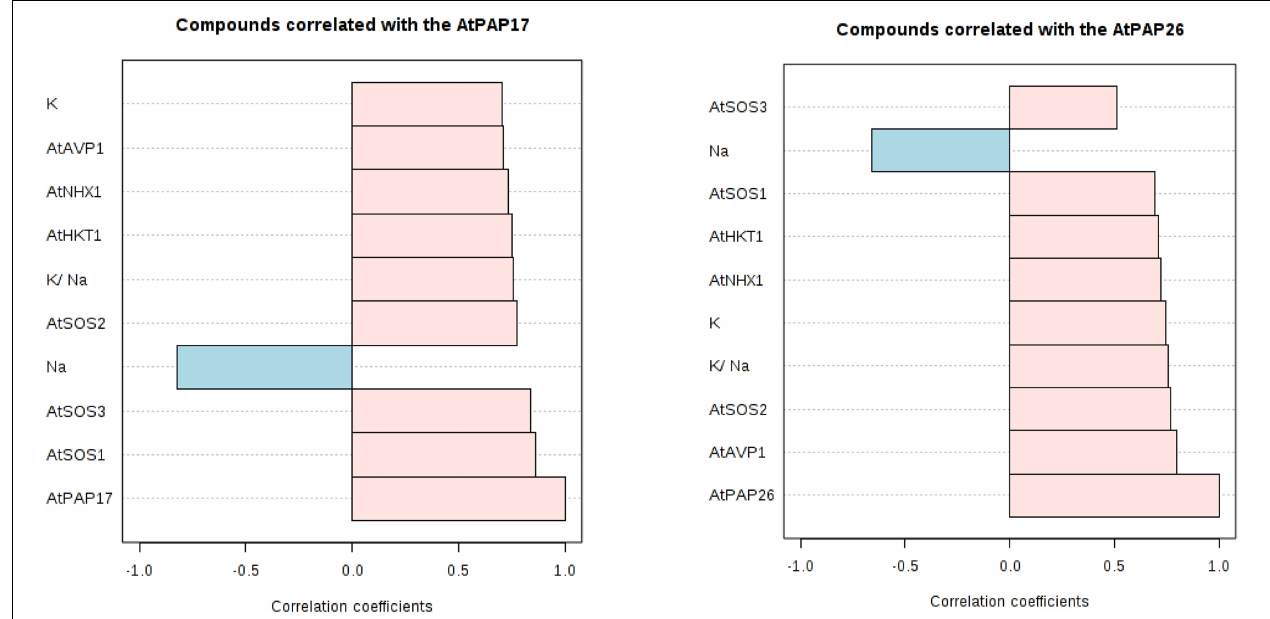
FIGURE 9 | Correlation coefficients between the expression level of AtPAP17 and AtPAP26 genes and the expression level of AtSOS1, AtSOS2, AtSOS3, AtHKT1, AtVPV1 , and AtNHX1 genes; Na + and K + accumulation; K + / Na + ratio at 150 mM NaCl stress.